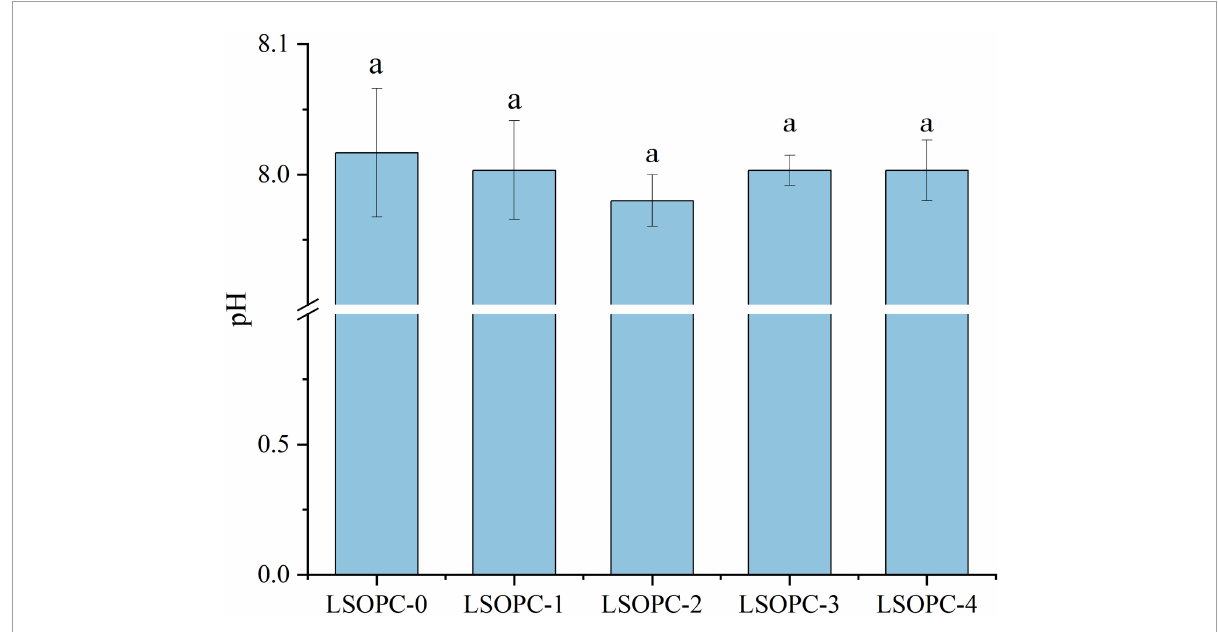
FIGURE5 Effects of different concentrations of LSOPC on pH in cookies. Significant differences ( p < 0.05) of data values were indicated by different letters.